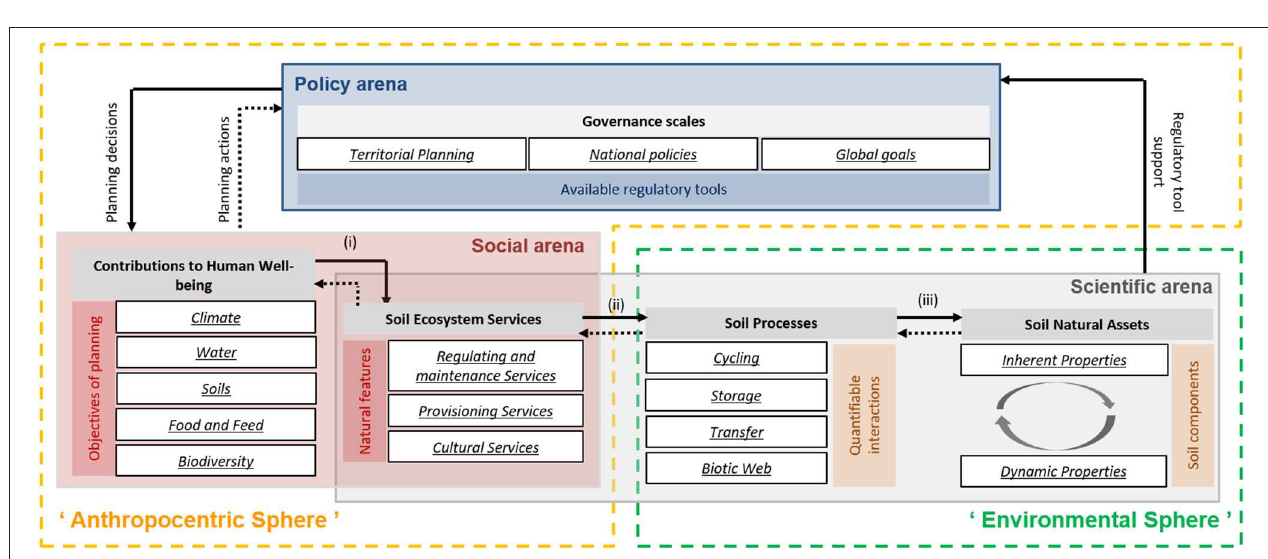
FIGURE 2 | Conceptual model connecting social, scientific and policy arenas, and anthropocentric and environmental spheres. Solid arrows indicate the effects of causal links and clarify the connections between the two terms “contributions” and “soil natural assets” (i, ii, iii); dotted arrows indicate the stepwise integration of soil ecosystem services in the decision-making